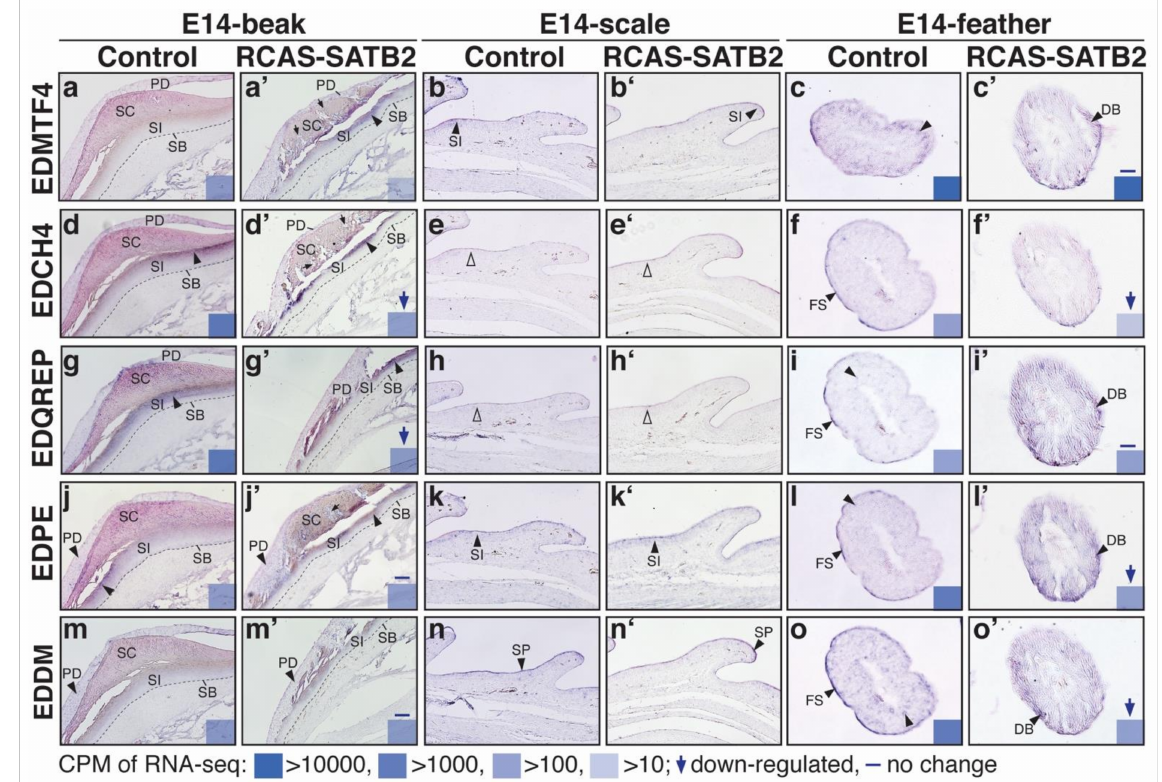
Figure 5. Altered expression patterns of selected non- β -keratin EDCs in beaks, scales, and feathers with SATB2- overexpression are studied by section in situ hybridization. Beaks and scales, sagittal sections. Feathers, cross sections. ( a – c , a’ – c’ ). In situ hybridization of EDMTF4; ( d – f , d’ – f’ ), EDCH4; ( g – i , g’ – i’ ), EDQREP; ( j – l , j’ – l’ ), EDPE; ( m – o , m’ – o’ ) and EDDM. Filled arrowheads indicate the location of in situ hybridization signals. The expression levels (CPM) of each gene from RNA-seq data, and disrupted trends when SATB2 is overexpressed, are indicated in the bottom right. Abbreviations: DB, downy barbules; FS, feather sheath; PD, periderm; SB, stratum basal; SC, stratum corneum; SI, stratum intermedium; SP,